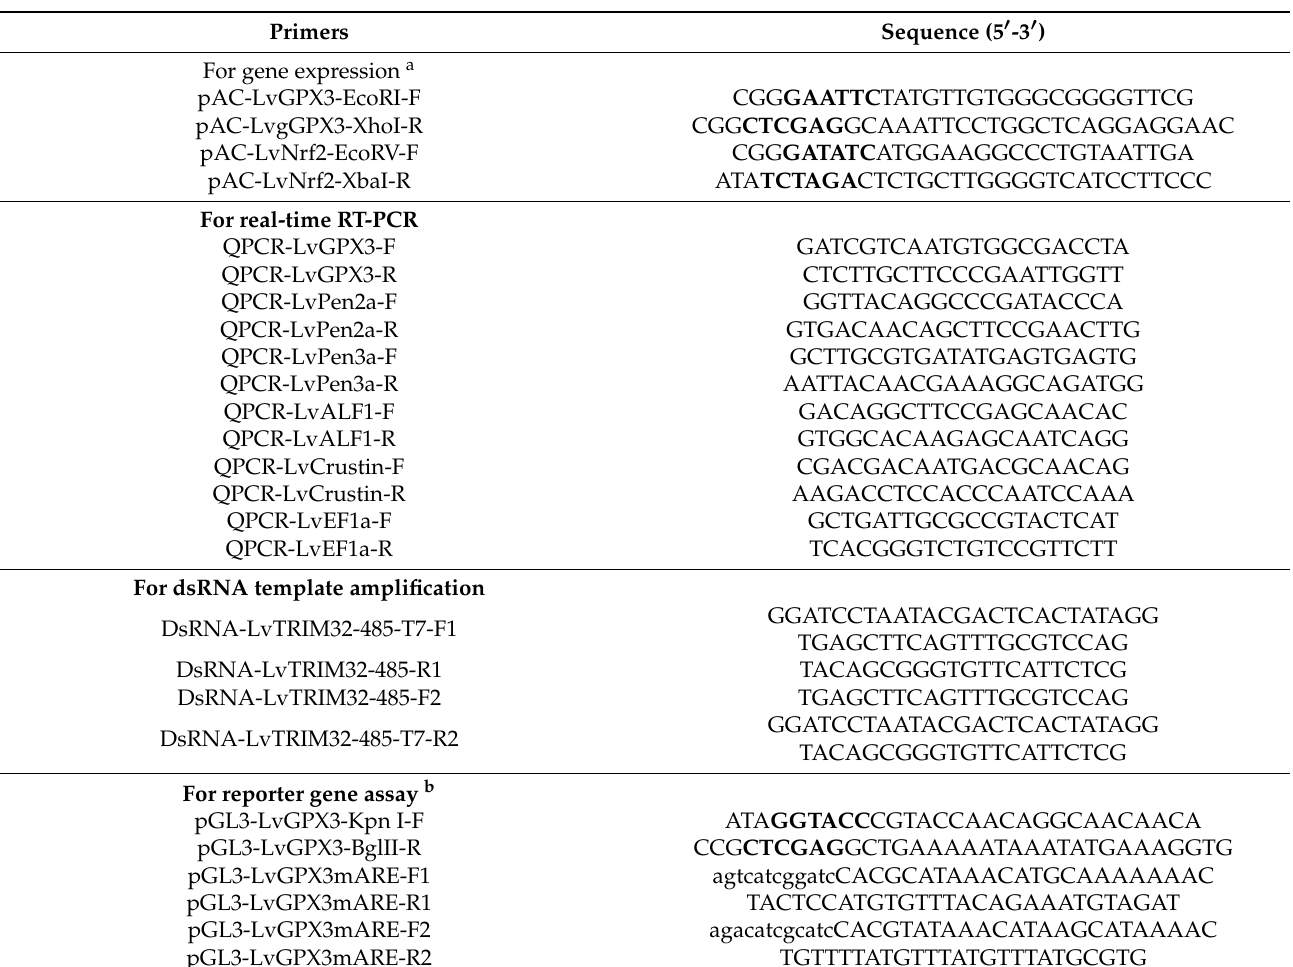
Table 1. Summary of primers used in this